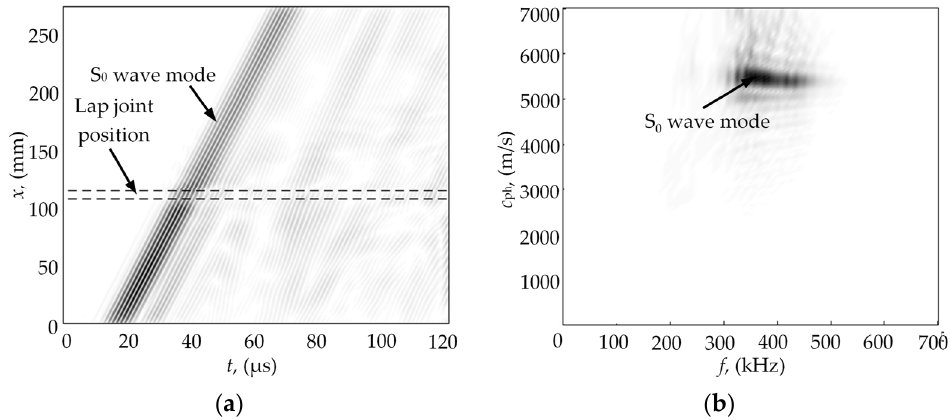
Figure 12. ( a ) Filtered B ‐ scan image of the ultrasonic guided waves propagating through the lap joint welded plates in the case of the 4 mm overlap zone width; ( b ) reconstructed guided waves dispersion curve pattern by using 2D FT from filtered data.